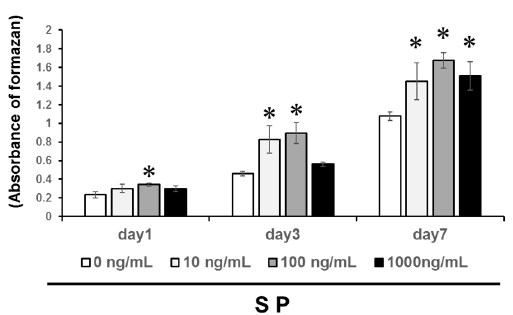
Figure 1. Dental pulp stem cell (DPSCs) were cultured with 0, 10, 100, and 1000 ng/mL synthetic amelogenin exon 5 encoded peptide (SP). Measurement of cell proliferation was investigated for 1, 3, and 7 days. Significant differences were determined compared with the control (SP, 0 ng/mL) (* P > 0.05).